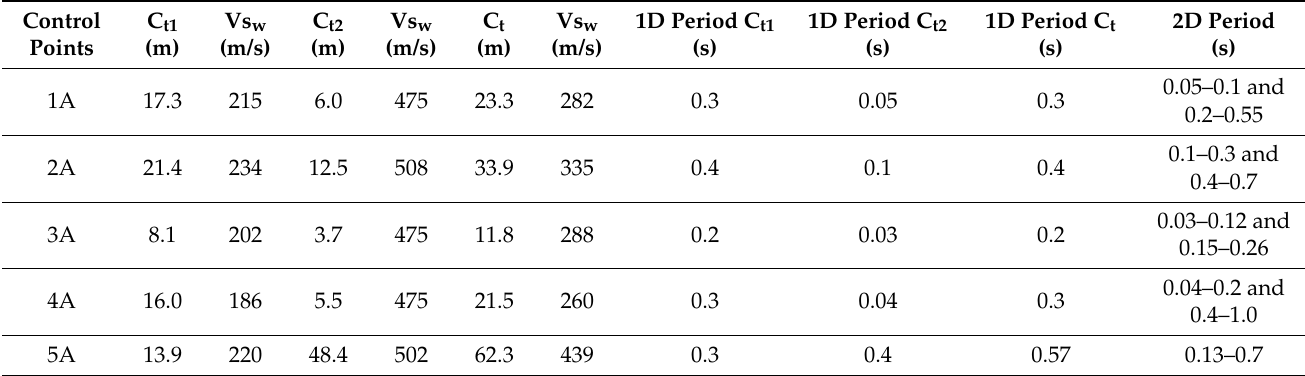
Table 7. Amplified periods calculated at 5 numerical control points along the sections AA (cid:48) .